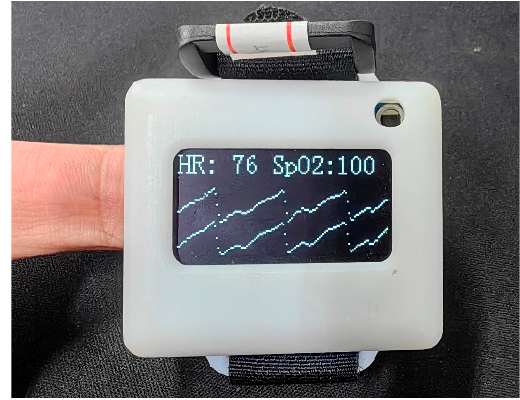
Figure 2. PPG data acquisition device.